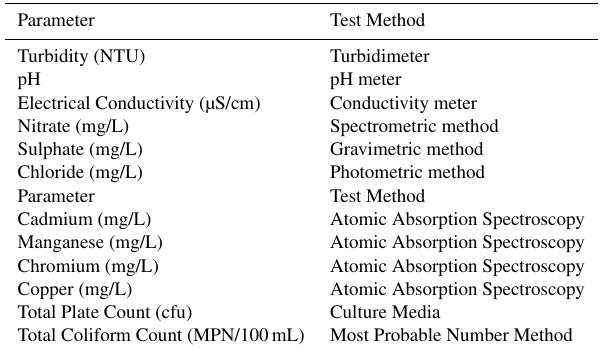
Figure 1. Study area with boreholes location (© Google Maps 2018). Table 1. Method for testing